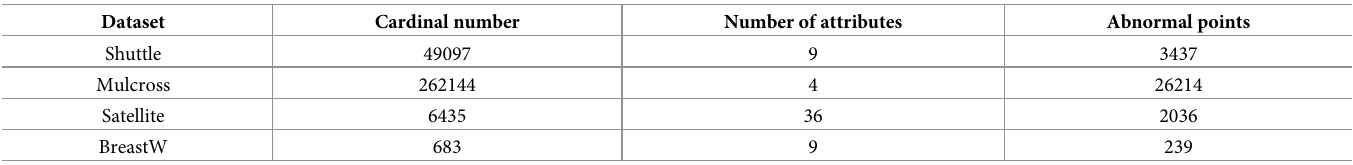
Table 1. Statistical characteristics of the other experimental dateset. Dataset Abnormal